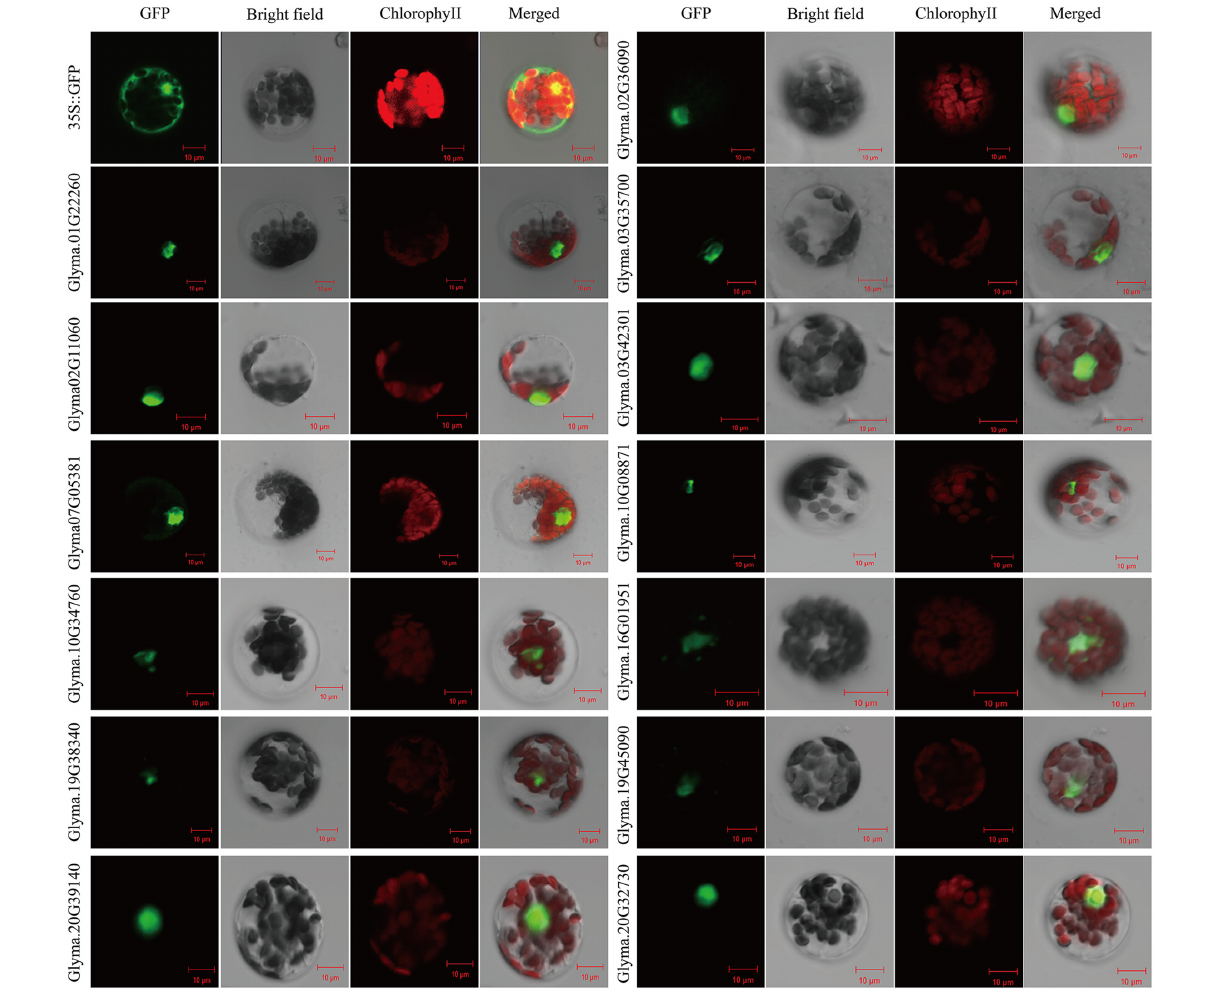
FIGURE 5 | Subcellular localization of the soybean RAV proteins. Results were visualized with confocal microscopy 16 h after transformation. Scale bars = 10 µ